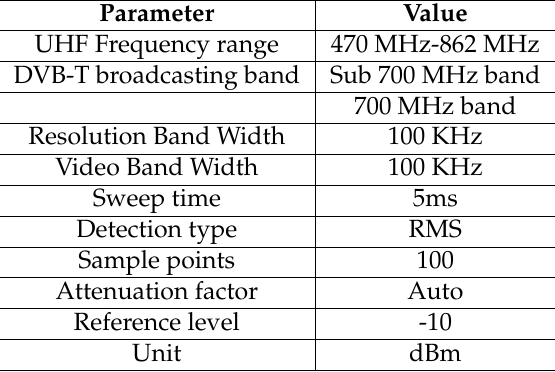
Table 1. Parameter configuration for the spectrum